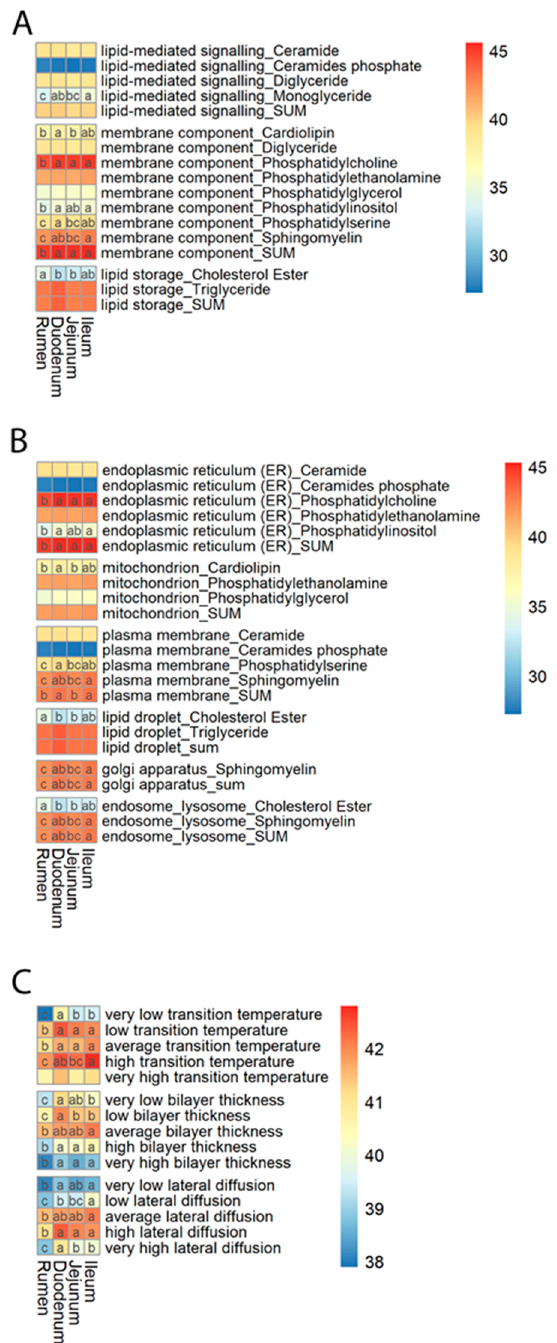
Figure 5. Signal counts of LION function terms in different LION term categories across the ruminal papillae and epithelium from duodenum, jejunum, and ileum of 5 lactating Holstein cows (( A ) func- tion, ( B ) cellular component, ( C ) transition temperature, bilayer thickness, and lateral diffusion.). Red denotes high signal counts, yellow median signal counts, and blue low signal counts in each lipid class. a,b,c Means with on the same row differ ( p < 0.05).